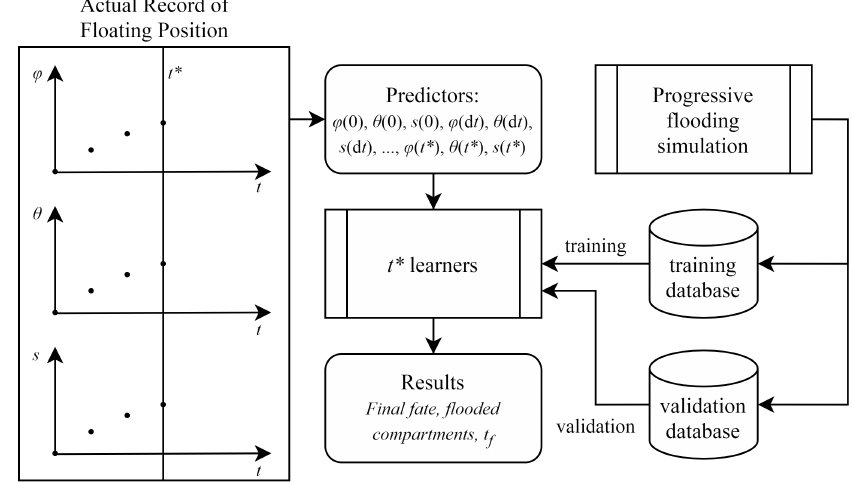
Figure 1. Flowchart of the classification